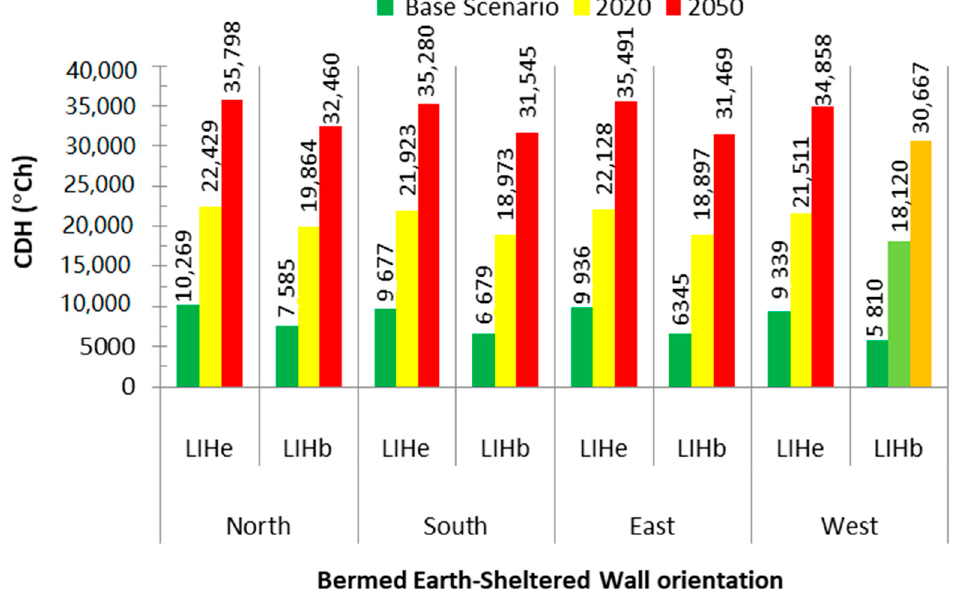
Figure 6. Weighted annual average cooling-degree hours (CDH) indicator in baseline and future scenarios (colors in west orientation for LIHb in the 2050s was changed to match with the colors established in the RTQ-R).